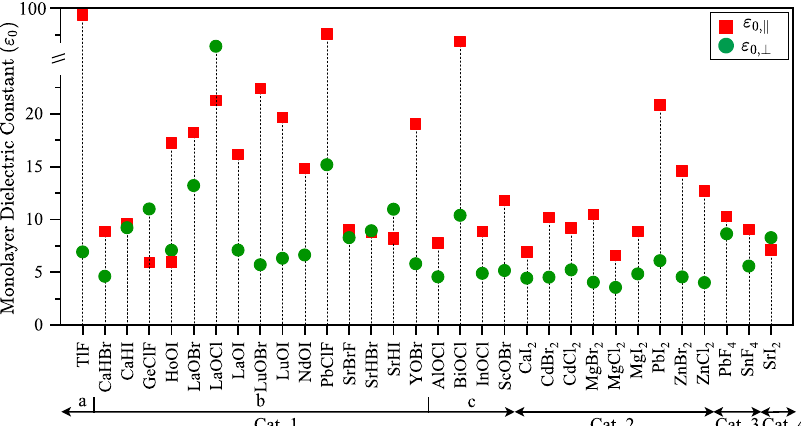
Fig. 2 The monolayer static in-plane and out-of-plane dielectric constants of 32 layered vdW materials. Red squares and green circles respectively denote the in-plane and the out-of-plane dielectric constants. The monolayer in-plane dielectric values range from 5.9 (GeClF) to 98.4 (TlF), and the out- of-plane dielectric values range from 3.6 (MgCl 2 ) to 55.8 (LaOCl).